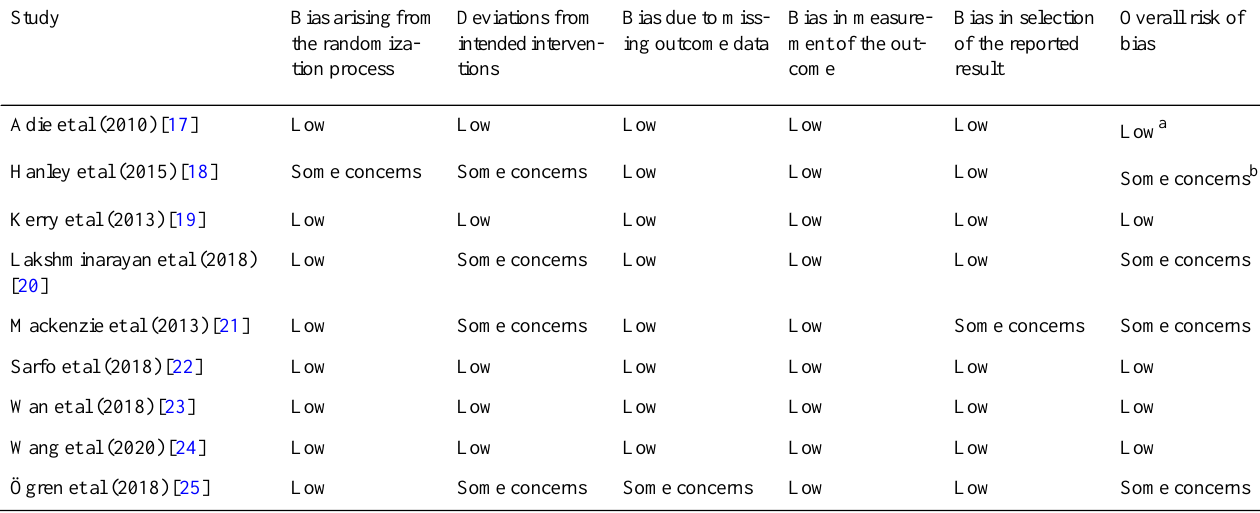
Table 1. Cochrane risk-of-bias tool for randomized controlled trials (RoB 2.0).